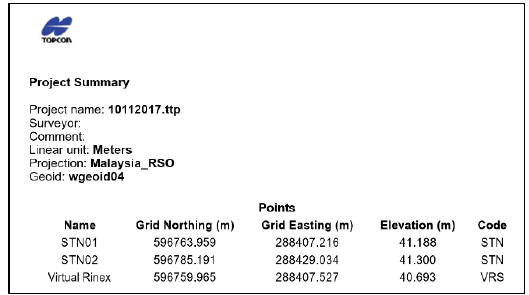
Figure 12. The example of final coordinates after post processing using Topcon Tools